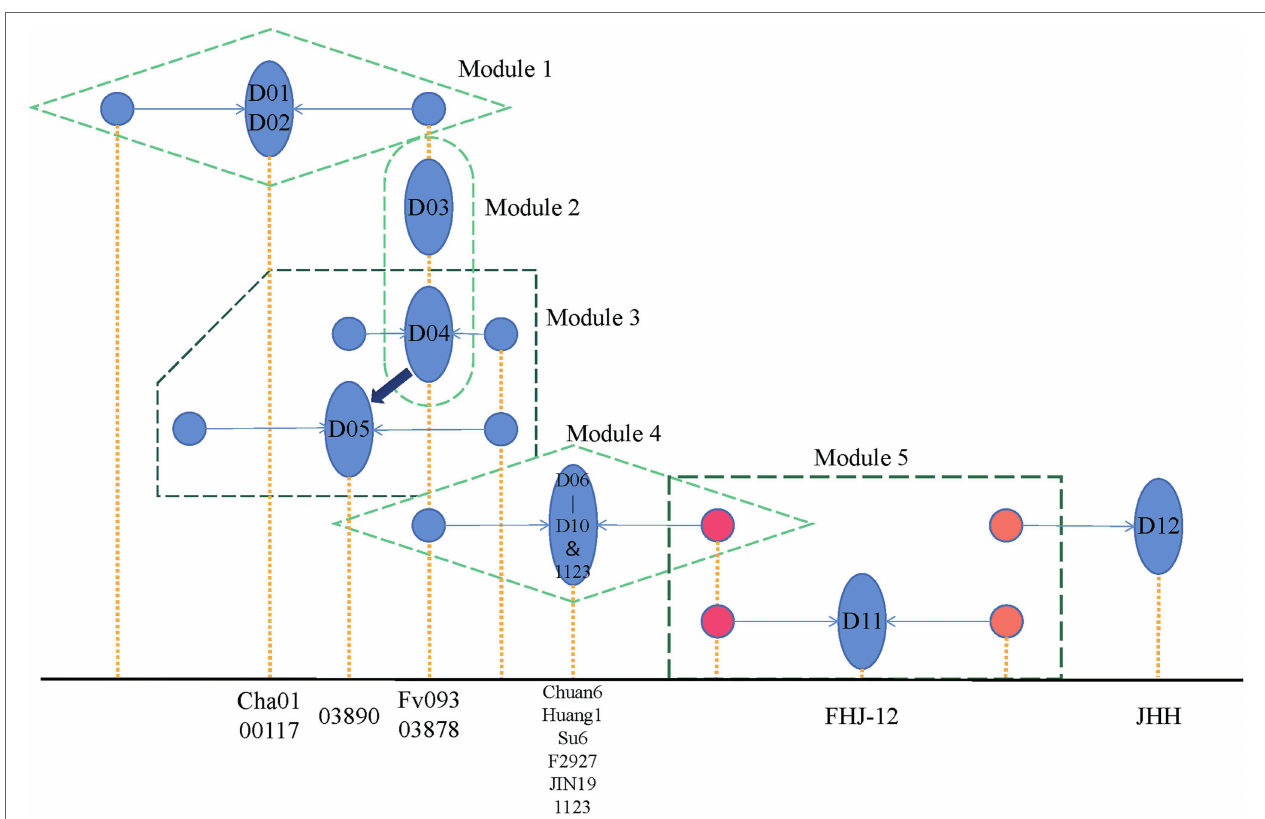
FIGURE 6 | Flammulina filiformis breeding history pattern. The blue ellipse represents the dual-nucleated strain, and the two associated monocytes connected by the arrow are represented by the blue circle. The x-axis position corresponding to the yellow dotted line represents the specific strain represented by the figure,